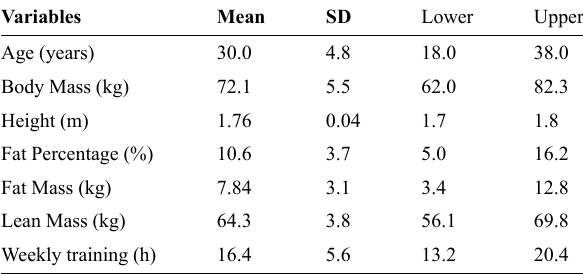
Table 1 - Descriptive data of the study